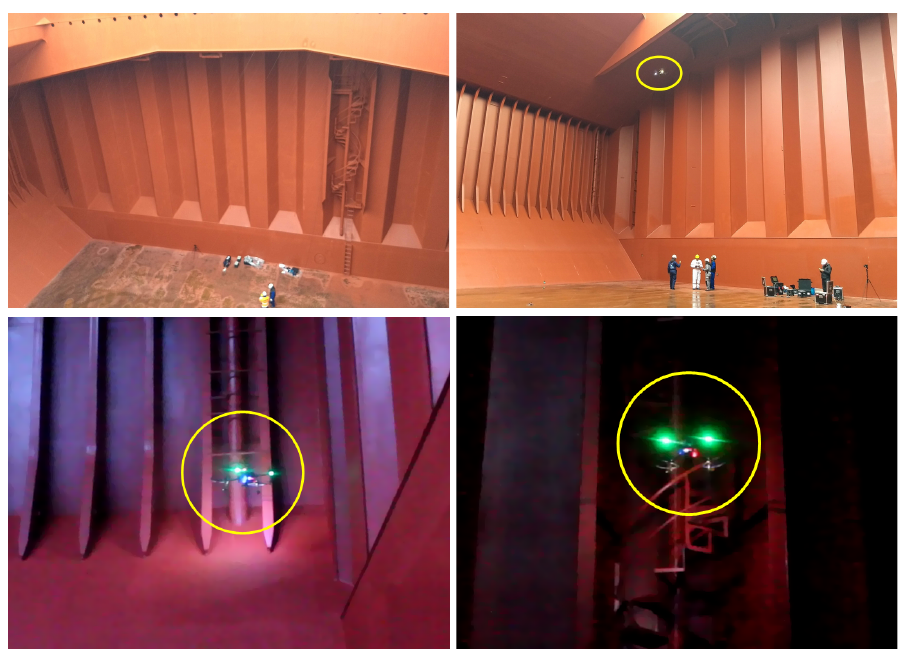
Figure 20. Pictures from field trials on-board a bulk carrier, with MUSSOL flying under normal and low-light conditions. In the rightmost and lowermost pictures, we highlight the robot during flight.